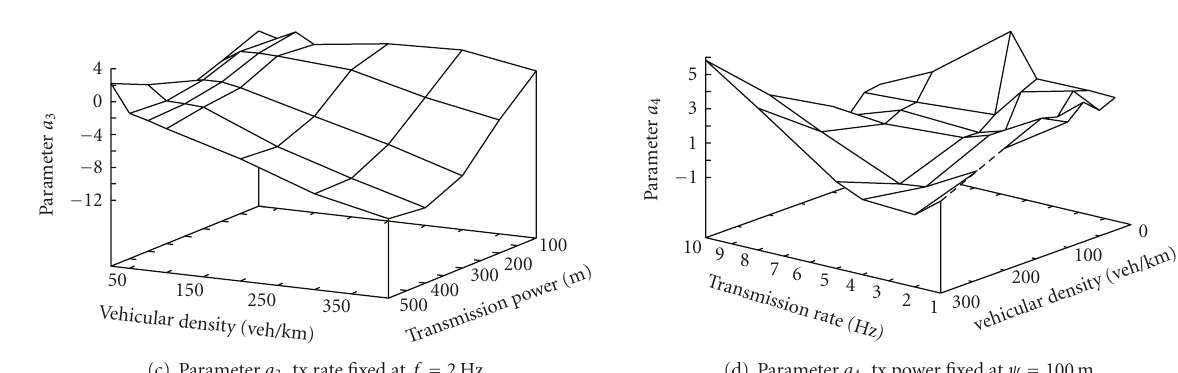
(d) Parameter a 4 , tx power fixed at ψ = 100m Figure 3: Fitting parameters a 1 through a 4 based on configuration